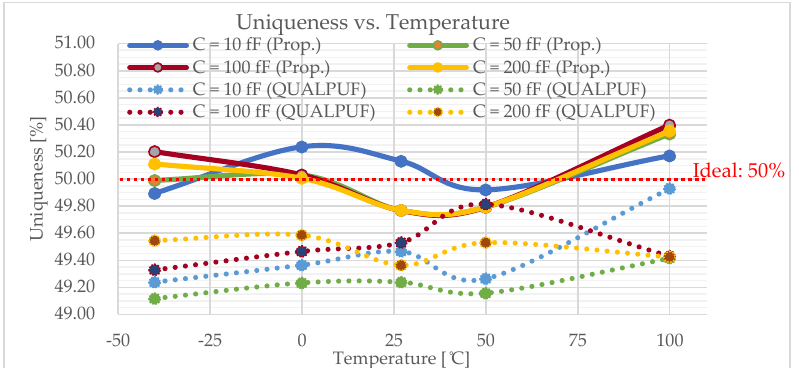
Figure 7. Energy consumption: ( a ) 10% of TOX variation and ( b ) 10% of V TH variation, with load capacitance varying from 10 to 200 fF.